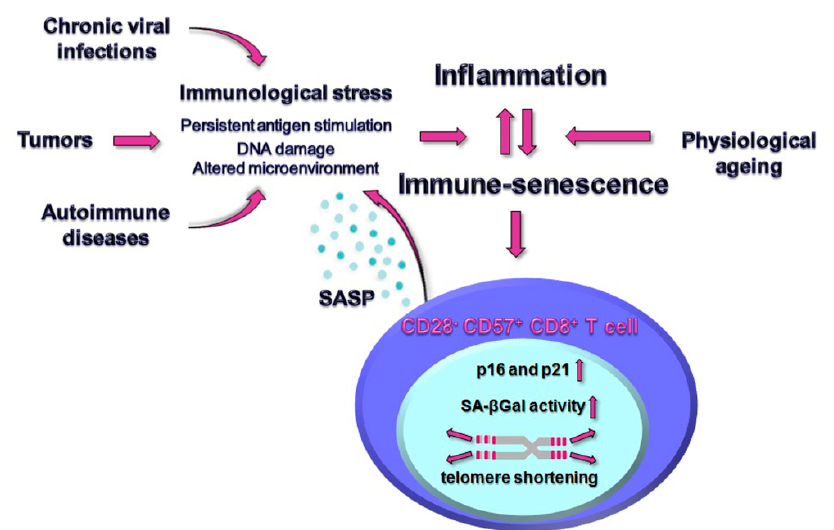
Figure 1. Immunological stress derived from chronic viral infections, autoimmune diseases and tumor conditions fuels the inflammation, typically of low grade during a healthy ageing, favoring the expansion of senescent CD28 − CD57 + CD8 + T cells that, despite the telomere shortening, the higher nuclear p16 and p21 expression, the DNA damage foci could retain proliferative capability and release proteases, interleukins, chemokines and pro-inflammatory factors that feature the specialized secretory activity termed senescence associated secretory phenotype (SASP), thus contributing to the overall inflammation. Senescence-associated β -galactosidase (SA- β Gal) activity displays an age-associated increase in CD8+ T cell populations.